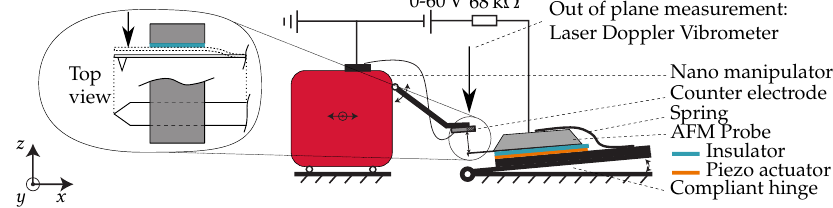
Figure 4. Experimental setup. A robotic nano-manipulator is used to position the electrode relative to a commercially available cantilever. The Atomic Force Microscopy (AFM) probe is actuated with a piezoelectric actuator and the frequency response is measured with a laser Doppler vibrometer for a varying electrode position along the length of the cantilever.